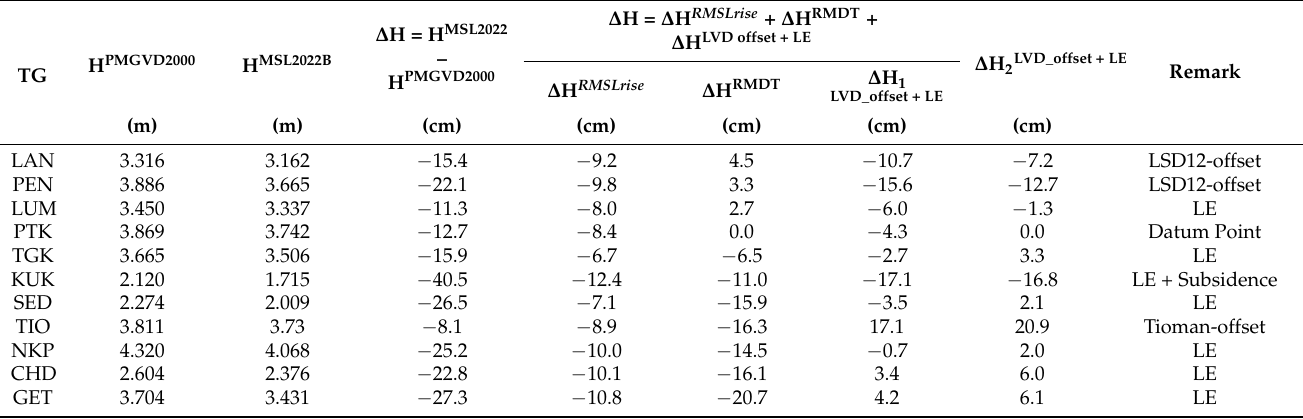
Table 14. PMGVD2000 datum inconsistencies due to relative MSL rise, sea slopes (RMDT), local vertical datum offset (LVD-offset), and levelling error